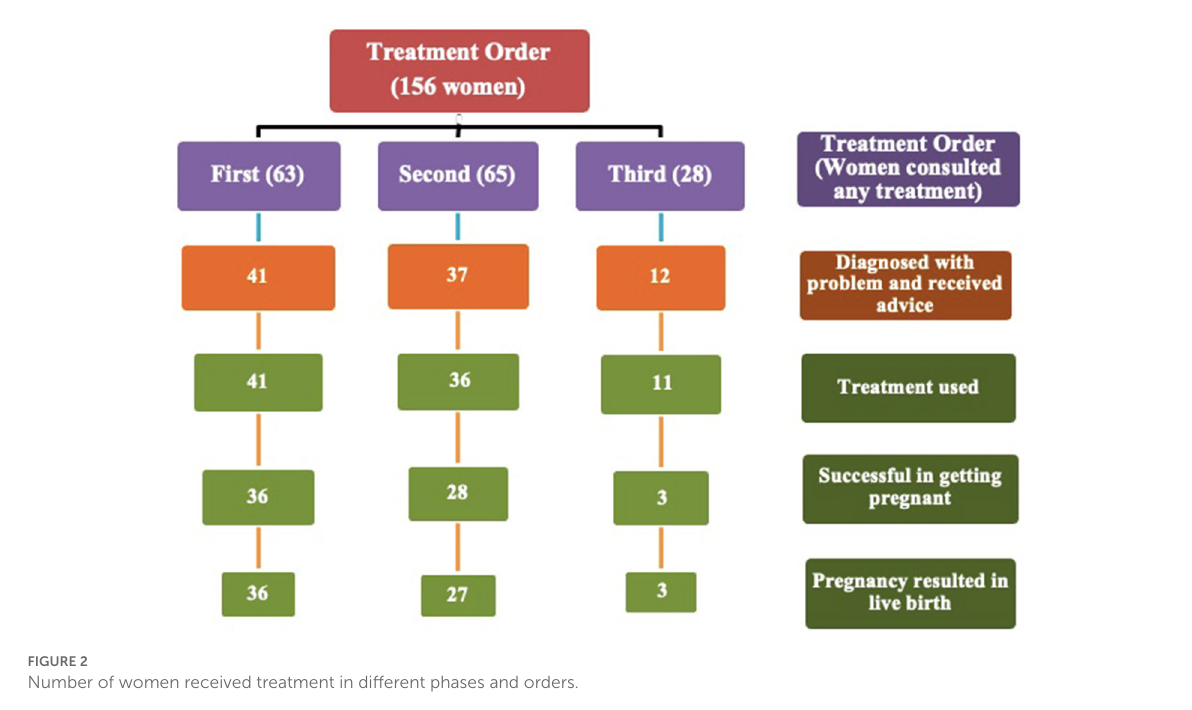
FIGURE2 Number of women received treatment in different phases and orders.